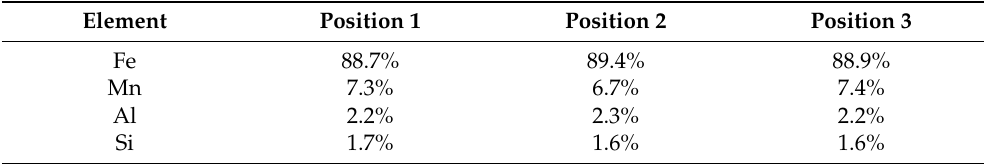
Figure 6. ( a ) SEM micrograph showing the microstructure of a specimen tested to fracture at 175 °C. ( b ) EBSD phase map of ( a ). The deformation-induced structure has been indexed to be bcc phase, as marked by yellow arrows. F: ferrite. Blue color represents fcc phase, red color represents bcc phase, and black color represents unindexed points. White stars are registration marks. Figure 7. TEM ( a ) bright field ( b ) dark field images from a specimen tested at 175 °C to an elongation of 30%. The morphology of DIBs is the typical sheaf morphology of conventional bainite. EDS re- sults from positions 1 to 3 are given in Table 2. The insert SADP in ( a ) is from the beam direction [111] of bainite. ( c ) The SADP was from the area marked by the dotted circle in ( a ) and tilted to the new beam direction. SADP from an area included both DIB and austenite matrix. This SADP is from the beam direction [001] of bainite and [011] of austenite. The red and blue indexes are for bainite and austenite, respectively. Table 2. EDS results from positions 1, 2 and 3 marked in Figure 7a. The value of each element is a result of normalizing with the sum of the four elements to 100%.